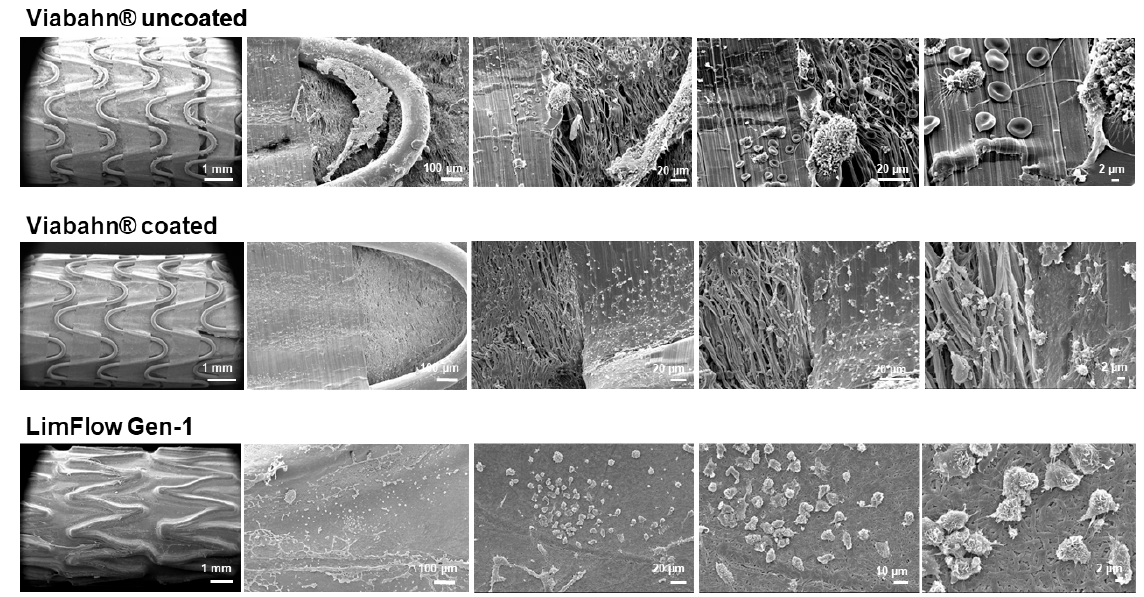
Figure 9. Analysis of the blood-contacting surface of stent grafts using SEM. Detection of the thrombogenicity in experiment series A. Representative images from one donor are shown after the blood contact ( n = 3).